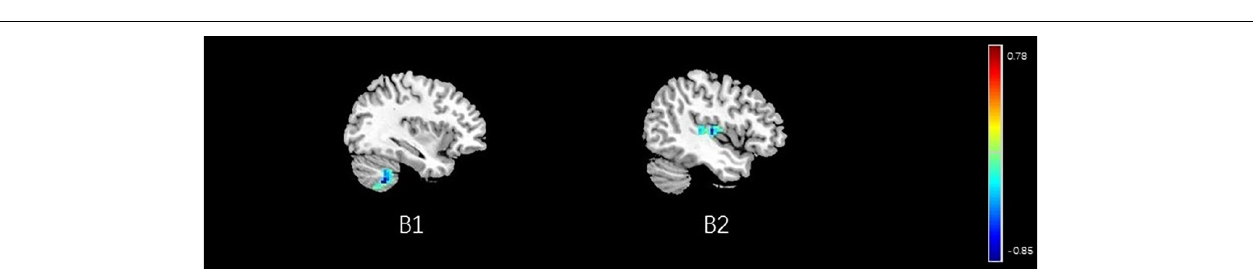
FIGURE 12 | Regions showing significant correlation with the pain score of placebo response in female participants. Color scale represents the correlation coefficient. Red = positive correlation; blue = negative correlation. A1: cerebellum posterior lobe, A2: thalamus, A3: insular, A4: secondary somatosensory area.